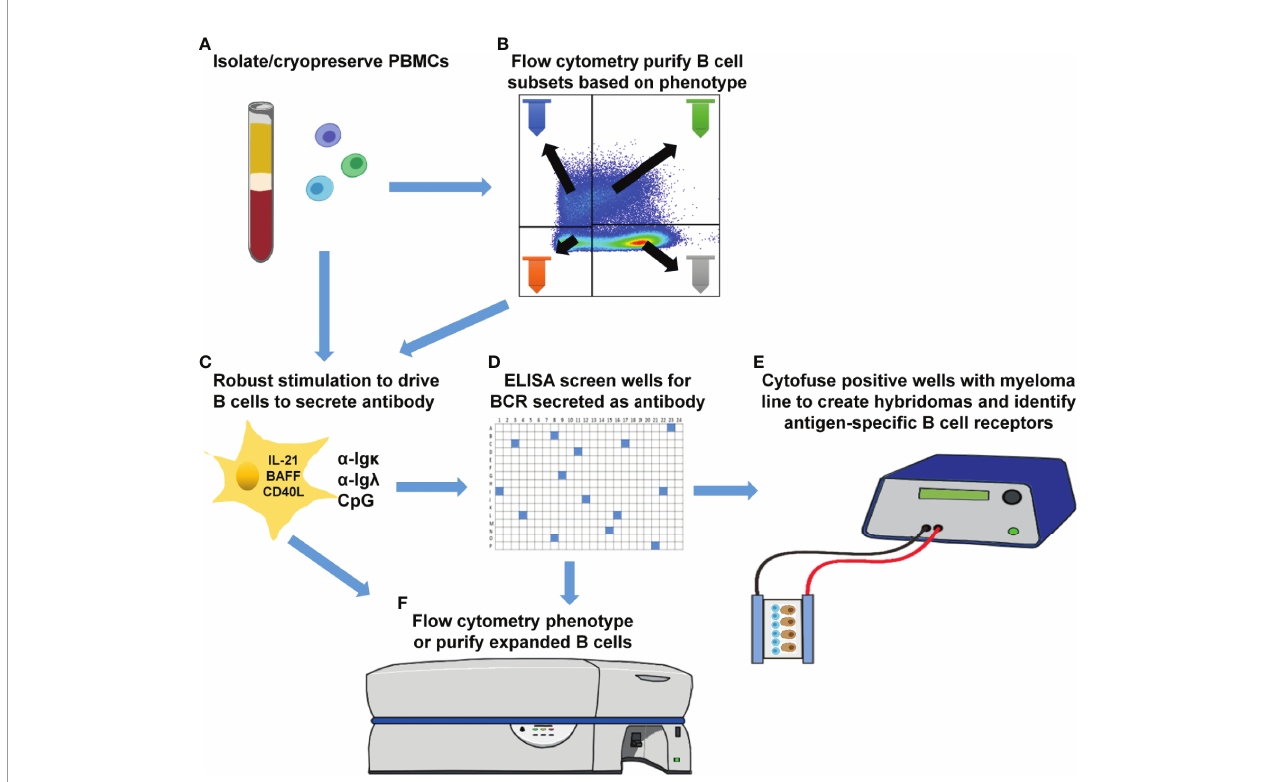
FIGURE 7 | Downstream applications for methods to phenotypically-de fi ne, expand, and identify ASBCs. (A) Isolate and cryopreserve PBMCs. (B) Optionally purify speci fi c B cell subsets using fl ow cytometry cell sorting. (C) Plate total PBMCs (panel A ) or puri fi ed B cell subsets (panel B ) into 384-well plates and stimulate as in Methods to drive B cell proliferation and differentiation into antibody-secreting cells. (D) High-throughput ELISA screening of well supernatants to identify wells containing ASBCs. (E) Cytofuse candidate wells to produce human hybridoma lines or (F) enrich for ASBCs prior to fl ow cytometry